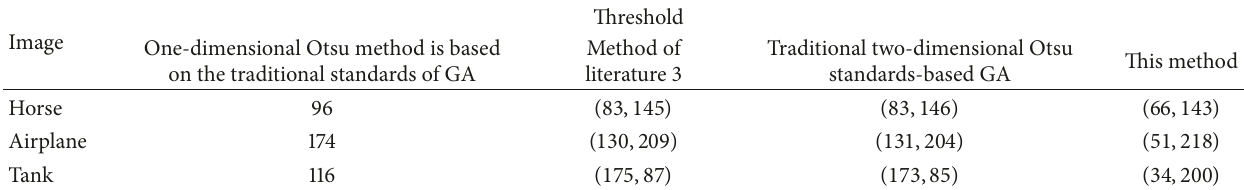
Table 1: The threshold obtained from several